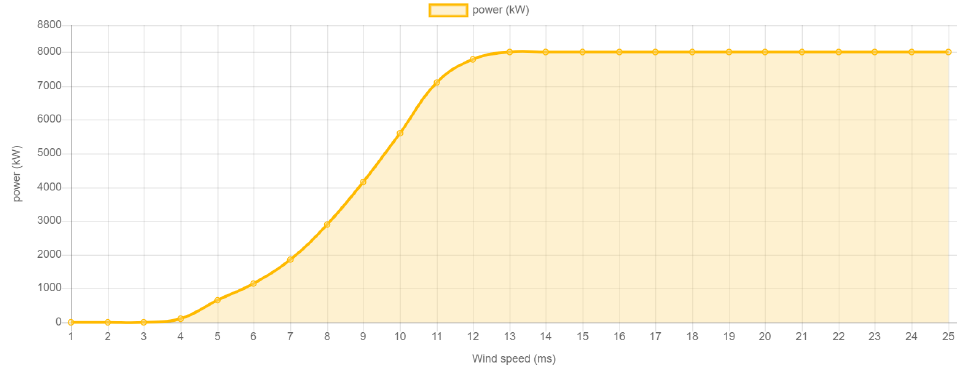
Figure 14. Power Curve of Vestas V164-8.0 (from